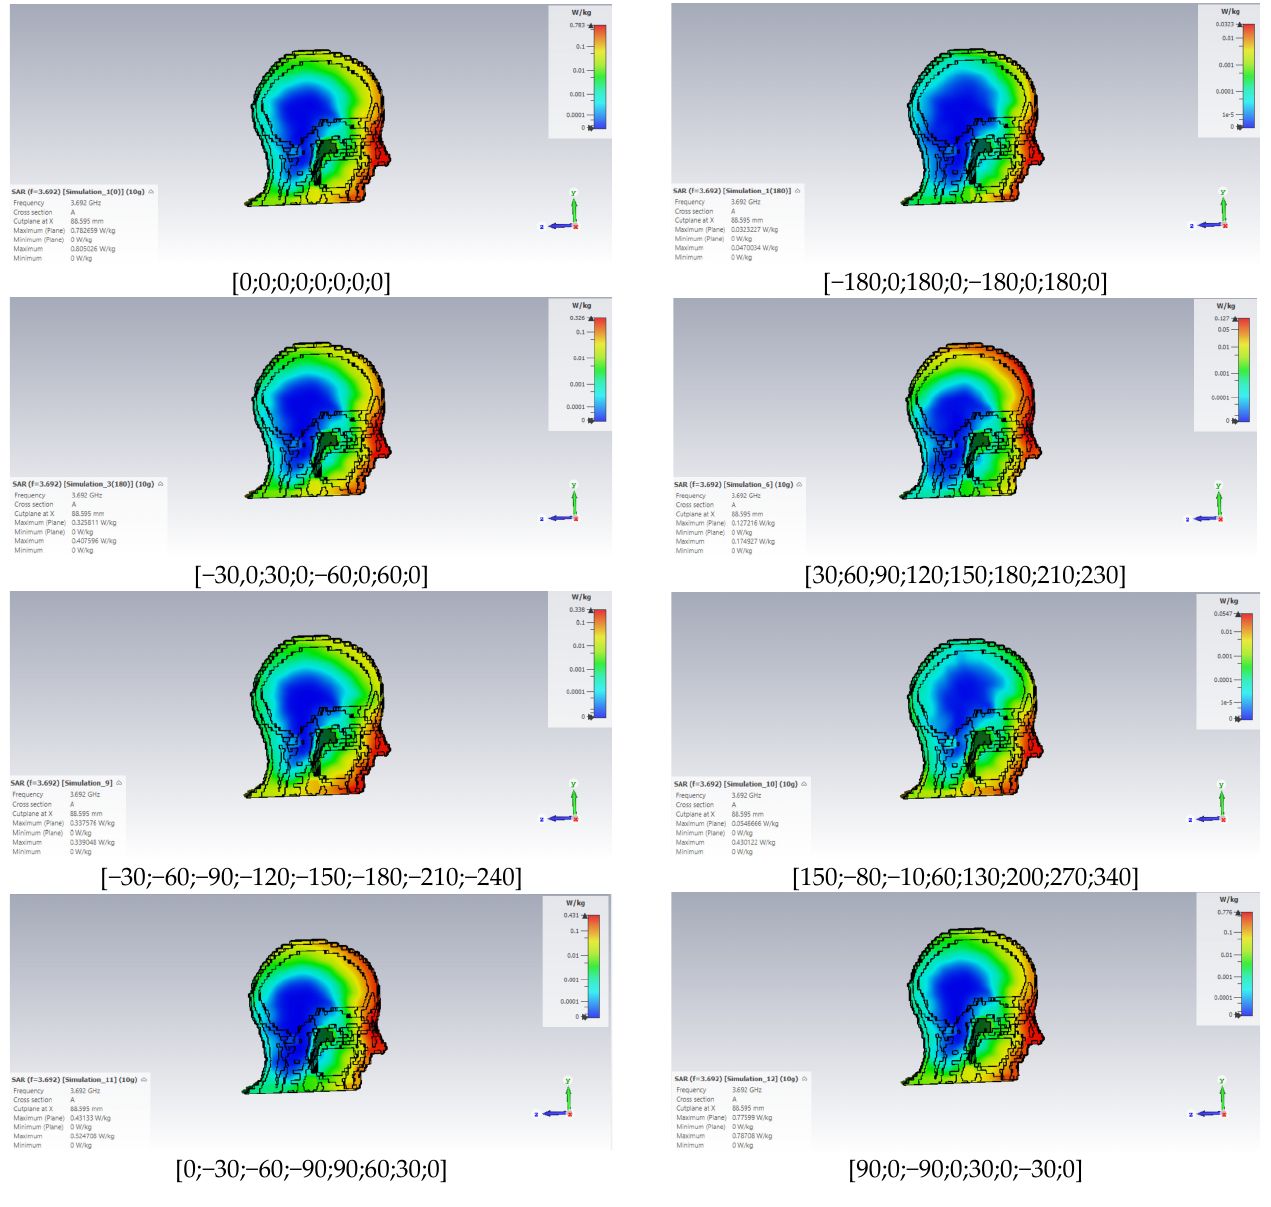
Figure 7. SAR10g (W/kg) distribution in a sagittal plane through the center of the head for the 2 × 4 planar antenna array, depending on phase difference/beam steering direction.